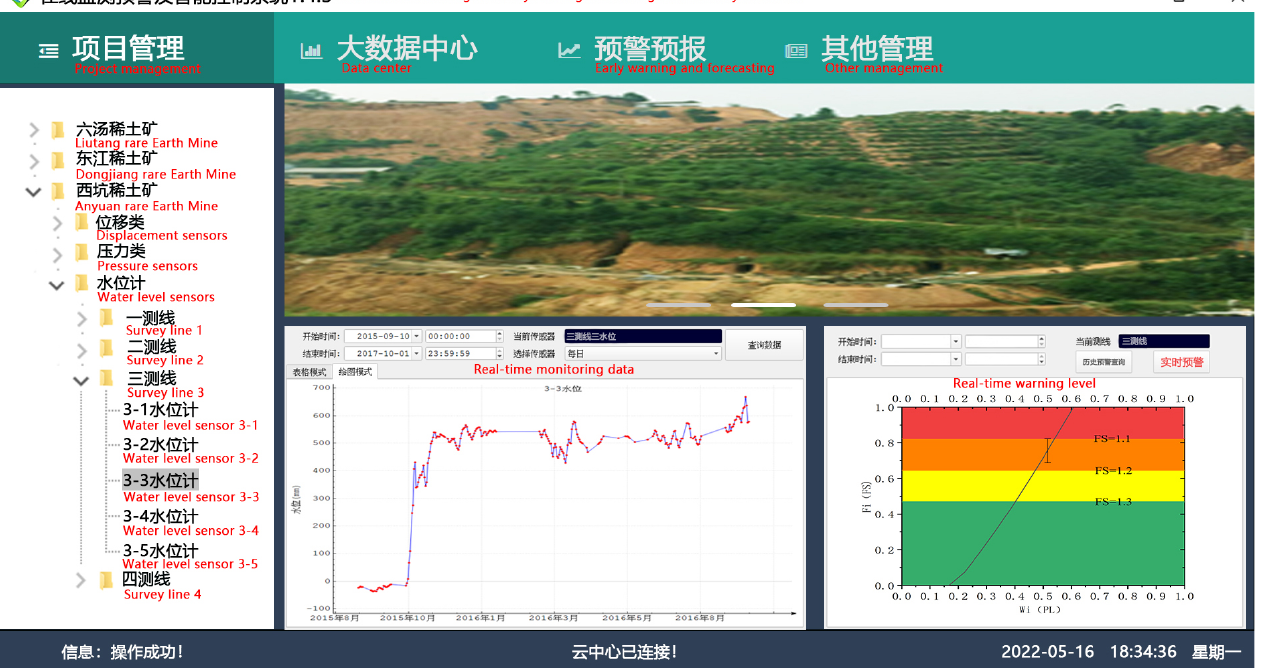
Figure 12. Self-developed landslide early warning